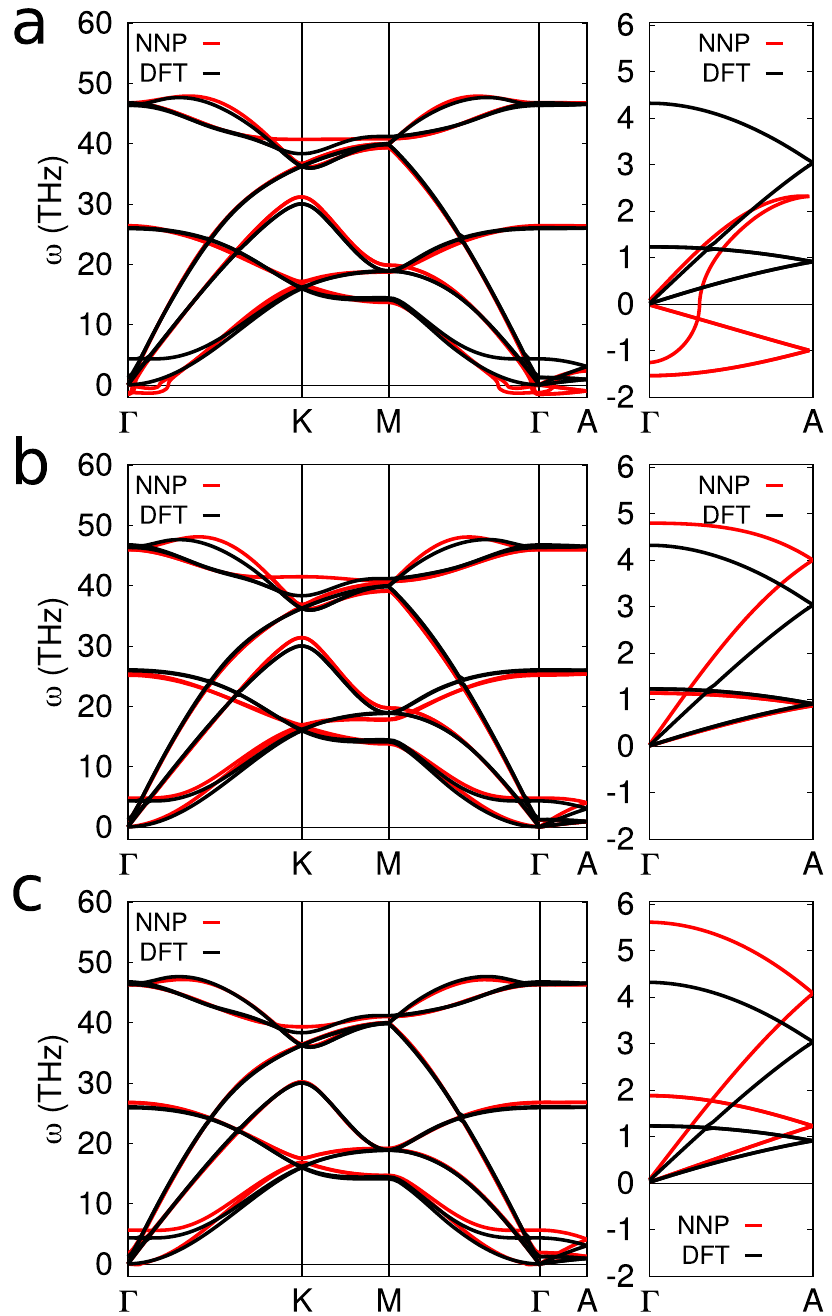
Fig. 5 Phonon dispersion of graphite. The phonon dispersion along the high symmetry lines is reported for a an NNP trained with the whole dataset at the last iteration, b an NNP retrained with the whole dataset but with the minimization of the relative error on forces, and c an NNP trained with all the data within D = 0.05 from diamond and graphite ( D 12 , as described in “ Discussion ” ). The small imaginary frequencies are lifted by modifying the NNP training loss function, or by training on data close to graphite in